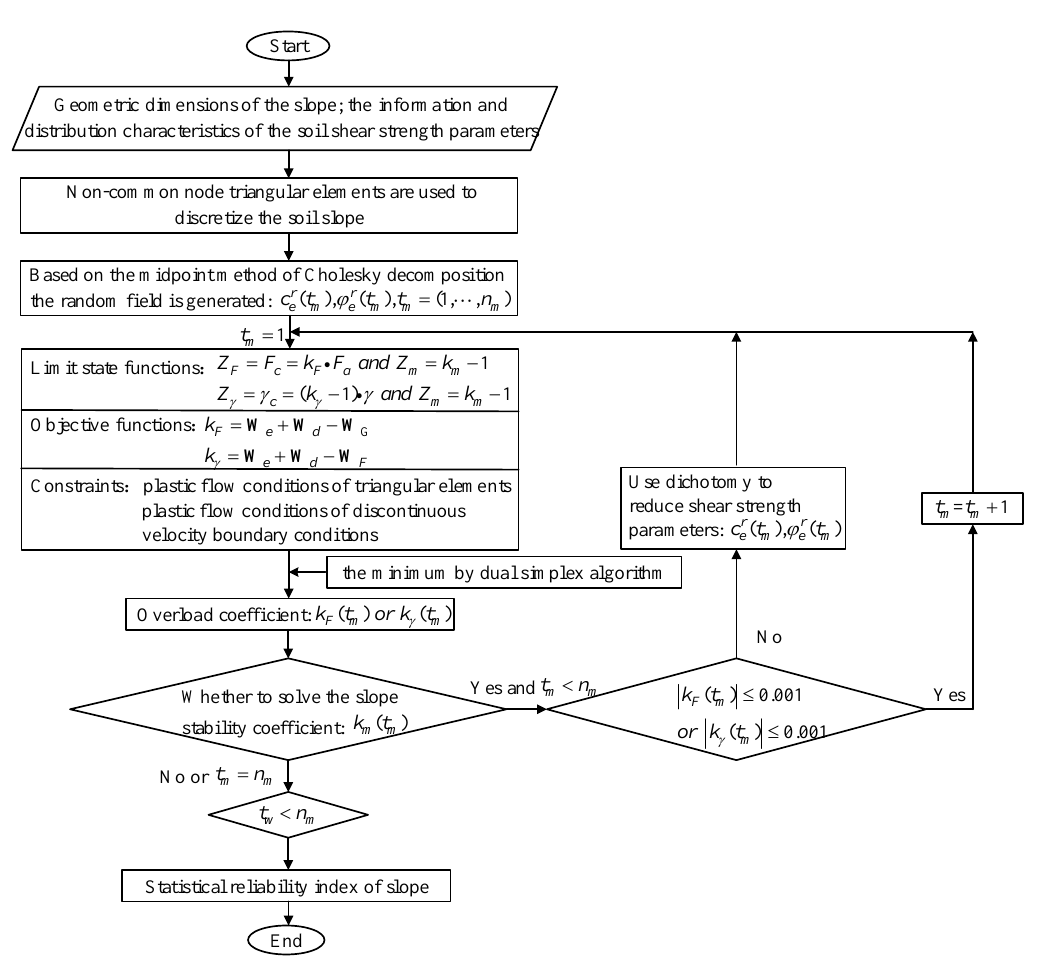
Figure 1. Flow chart of a numerical solution using UBM for a slope.